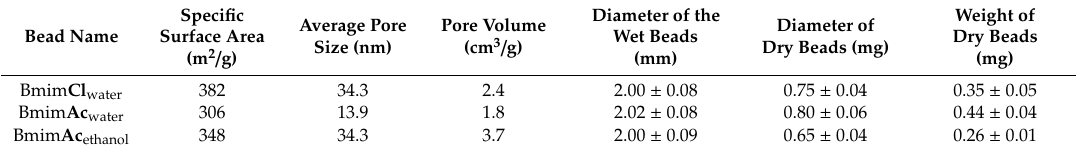
Table 3. Porosity characterisations of cellulose